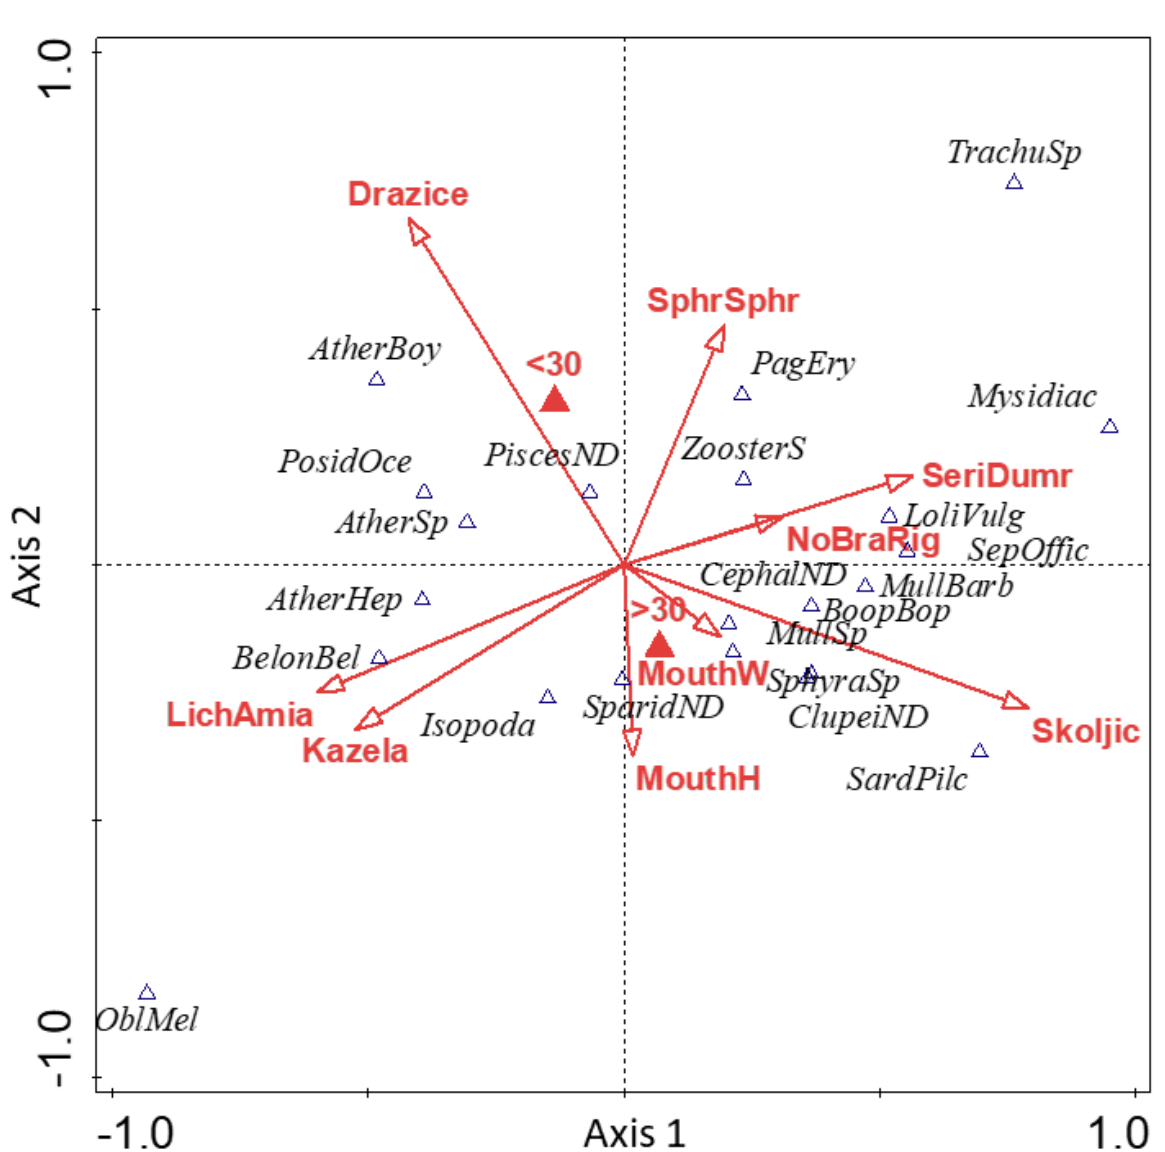
Figure 3. Canonical Correspondence Analysis (CCA) ordination diagram representing the mass percentage of main prey items consumed by three fish species ( Lichia amia, Seriola dumerili, Sphyraena sphyraena ) caught at each sampling site (Dražice, Kažela, Školjić) in the Bay of Medulin; Monte Carlo permutation test results on all axes: Pseudo-F = 2.0, p = 0.002 ( → explanatory variables, —specimen size class, Δ—prey item). See Table 1 and Appendix Table A1 for abbreviations. Table 2. Schoener index results based on IRI (underlined values) and mass frequency IRI (bold values) of feeding overlap of six thermophilic species caught in Bay of Medulin during 2017, 2018 and 2019.